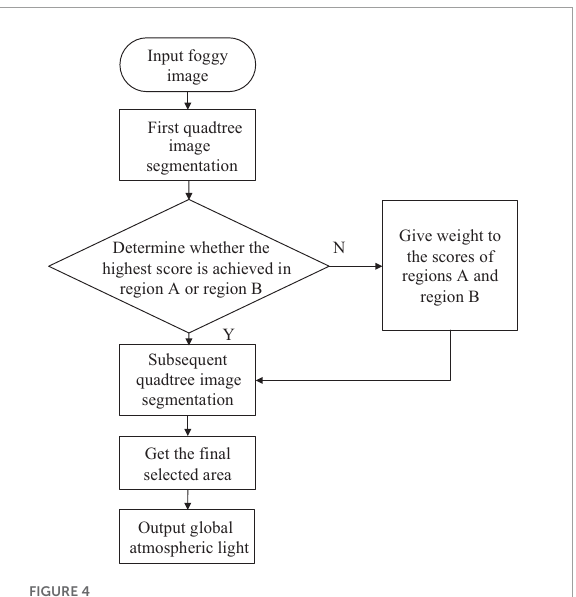
FIGURE4 Flowchart of the optimized quadtree segmentation algorithm.